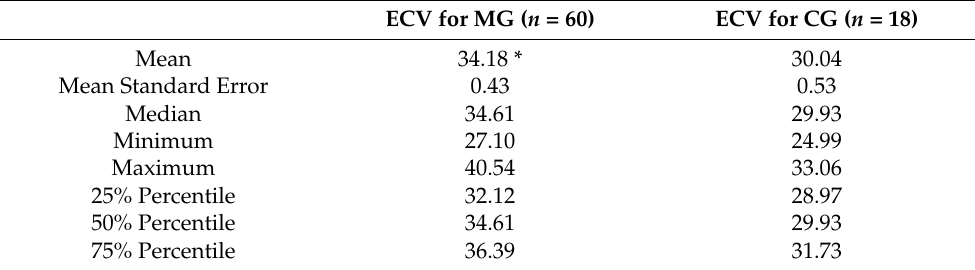
Table 2. Statistics of the ECV for both groups.